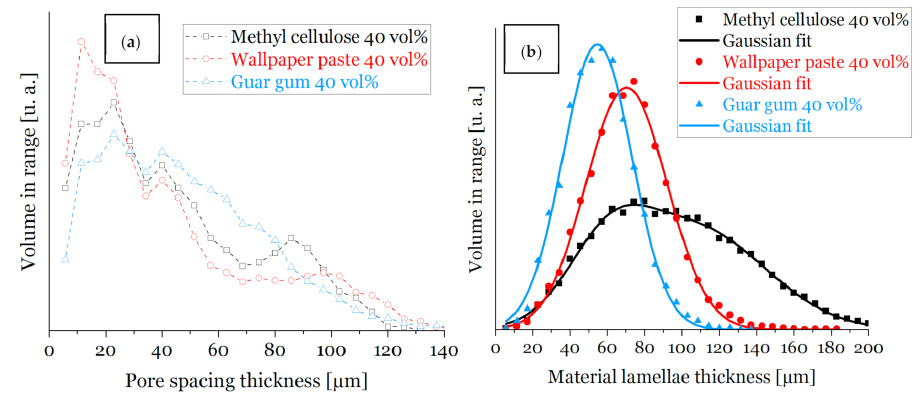
Figure 7. Distributions of the width of material lamella and pore spacings of sintered foam samples from dispersions with 40 vol.-% solid load measured by µ -CT; distribution of the ( a ) pore spacing thickness and ( b ) material lamella thickness of sample struts from sintered foam samples, respectively.Freeze-dried replica foams with starch flour as a thickening agent made from 30 vol% alumina dispersions broke during PU burnout; their stability was insufficient, most likely due to the high amount of lamellar pores within the foam